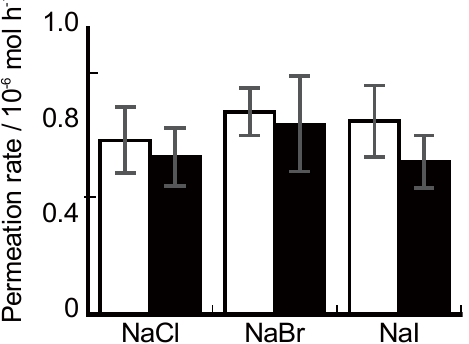
Figure 5. Permeability of alkali halides across (PAH-PSS) PAH films (filled column) with 1 mm diameter. The average values of three (PAH-PSS) 5 measurements are